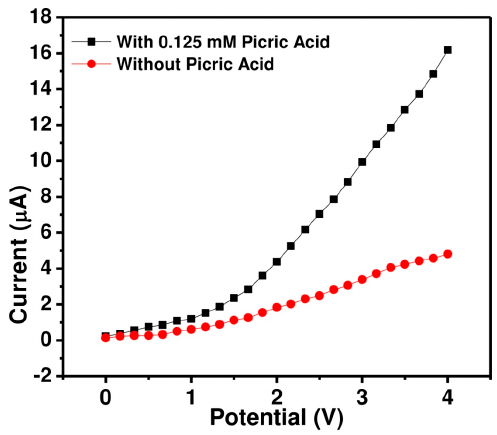
Figure 7. I-V performances for 0.125 mM picric acid and blank PBS using a ZnO nanopeanut-based AgE. Figure 8a depicts the effect of picric acid concentration on I-V responses. For 0.125, 0.25, 0.5, 1.0, 2.1, 3.0, 4.0, and 5.0 mM solutions of picric acid solution prepared in PBS, the corresponding current responses were 16.18, 29.48, 38.63, 47.58, 68.09, 78.53, and 90.49 μ A, respectively, measured at 4.0 V. This positive correlation can be explained on the basis of an increase in the ionic strength of the PBS